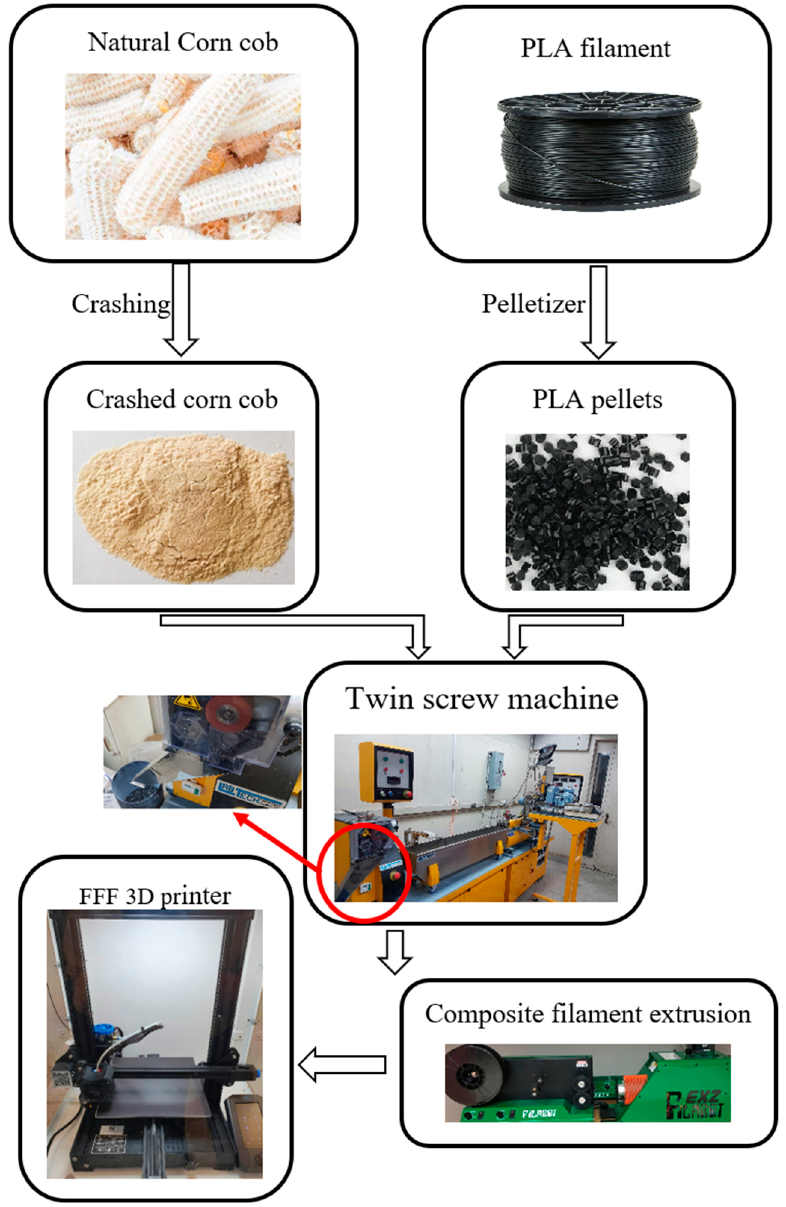
Figure 1. Flowchart of PLA-corn cob composite filament production and the fabrication of test specimens using an FDM 3D printer.